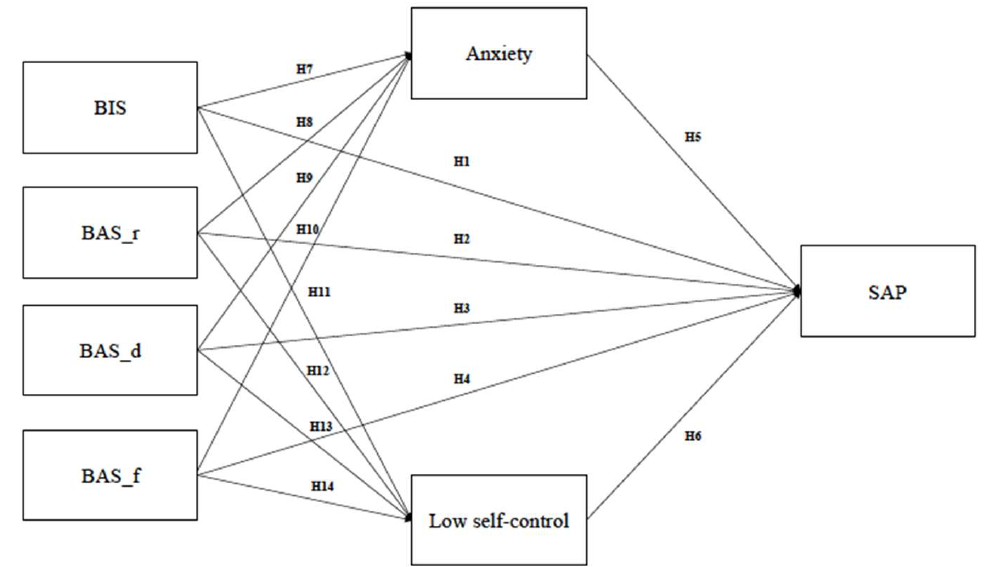
Figure 1. Hypothetical path model diagram. BIS = behavioral inhibition system; BAS_r = behavioral activation system_reward responsiveness; BAS_d = behavioral activation system_drive; BAS_f = behavioral activation system _fun seeking; SAP = Smartphone Addiction Proneness.